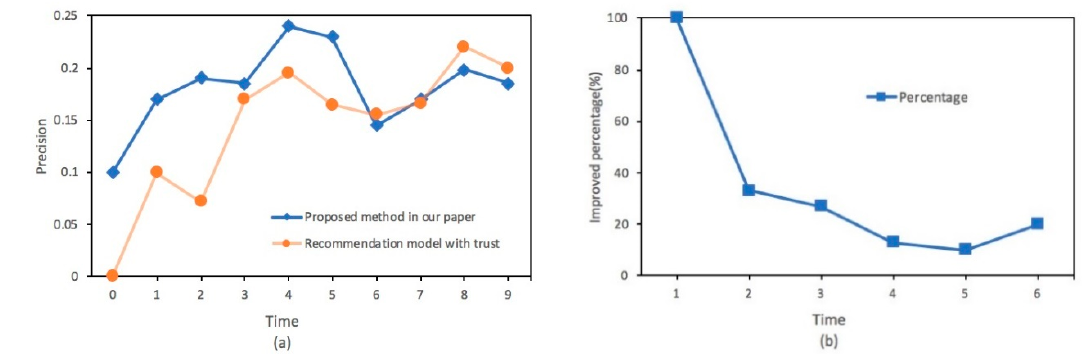
Figure 1. The result of the experiment. ( a ) The results of precision in a health and personal care shop; ( b ) the percentage of improvement of precision in the health and personal care shop.